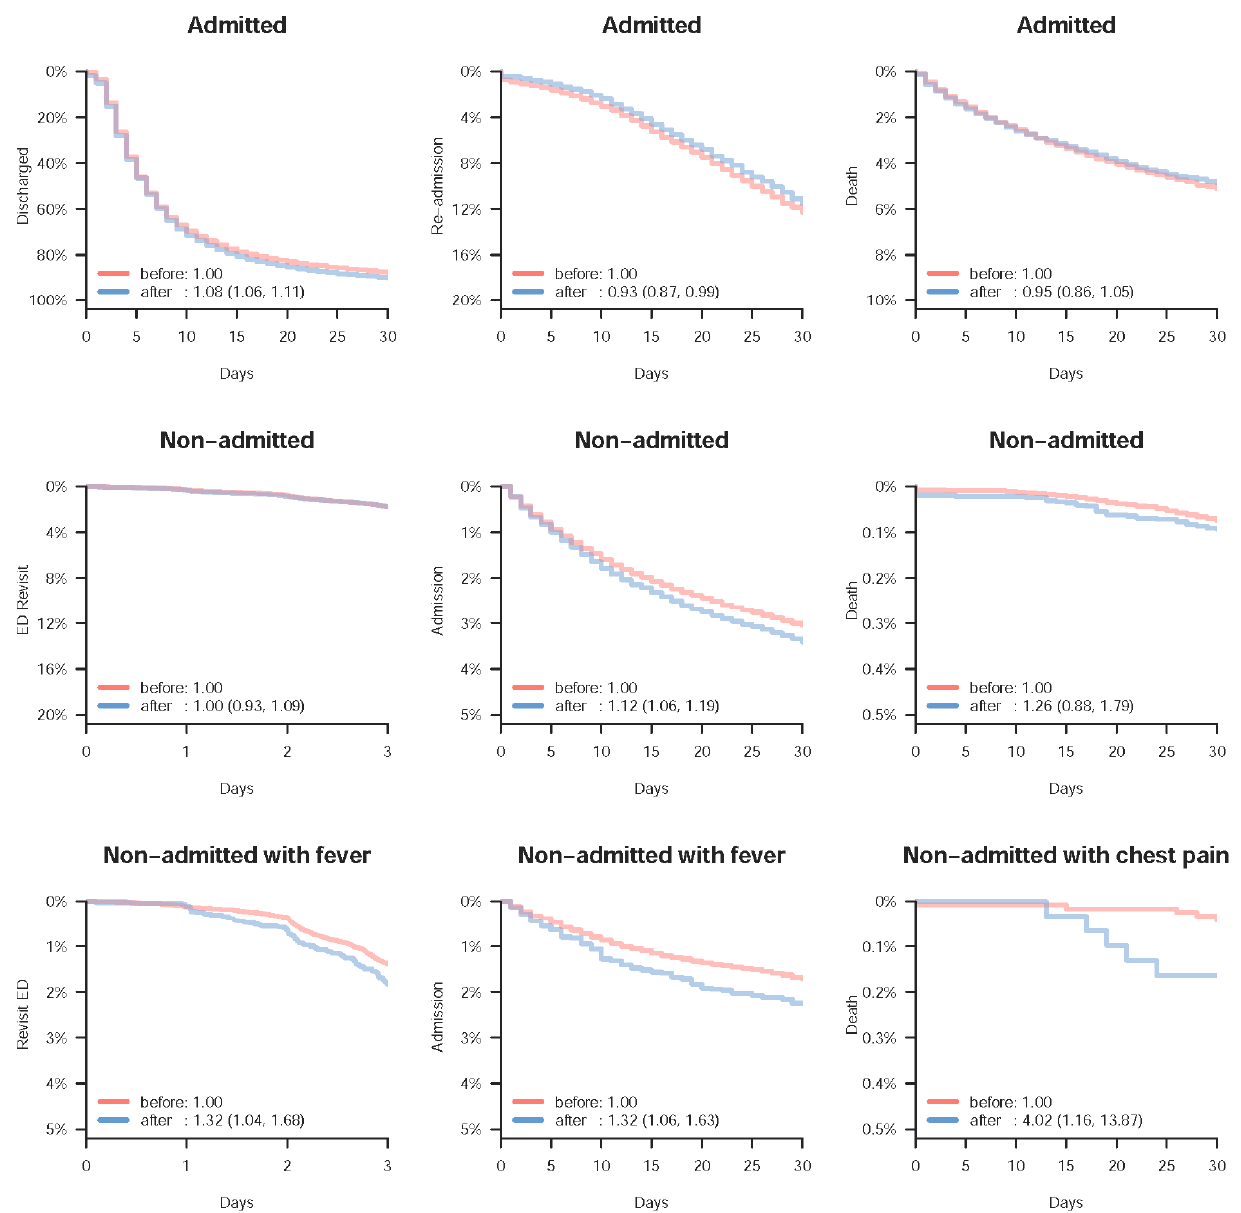
Figure 3. Important prognostic analysis of selected patient groups before and after the start of the COVID-19 pandemic. The Kaplan–Meier curve demonstrates the prognostic difference before (red) and after (blue) the start of the COVID-19 pandemic. Values in the legend are the hazard ratios and corresponding 95% conference intervals based on the Cox proportional hazard model.